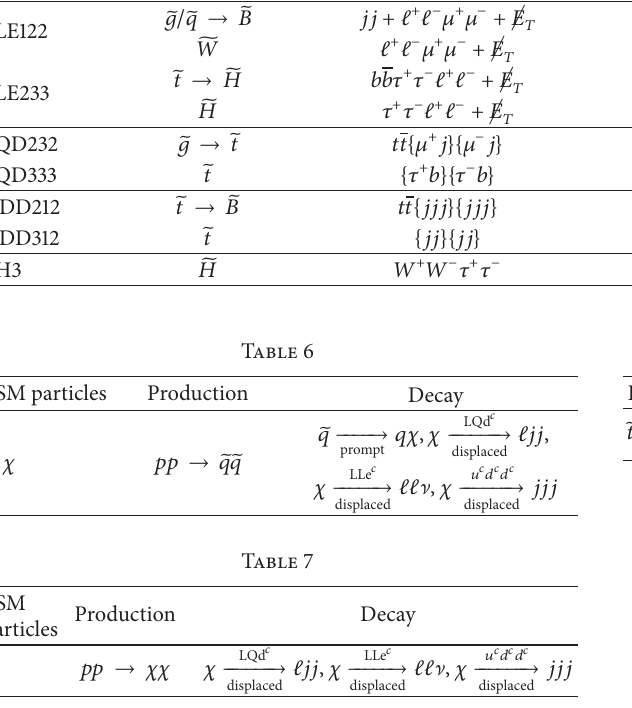
Table 5: The exclusion reach of several RPV SUSY simplified models beyond those discussed in the main text [6]. Coupling